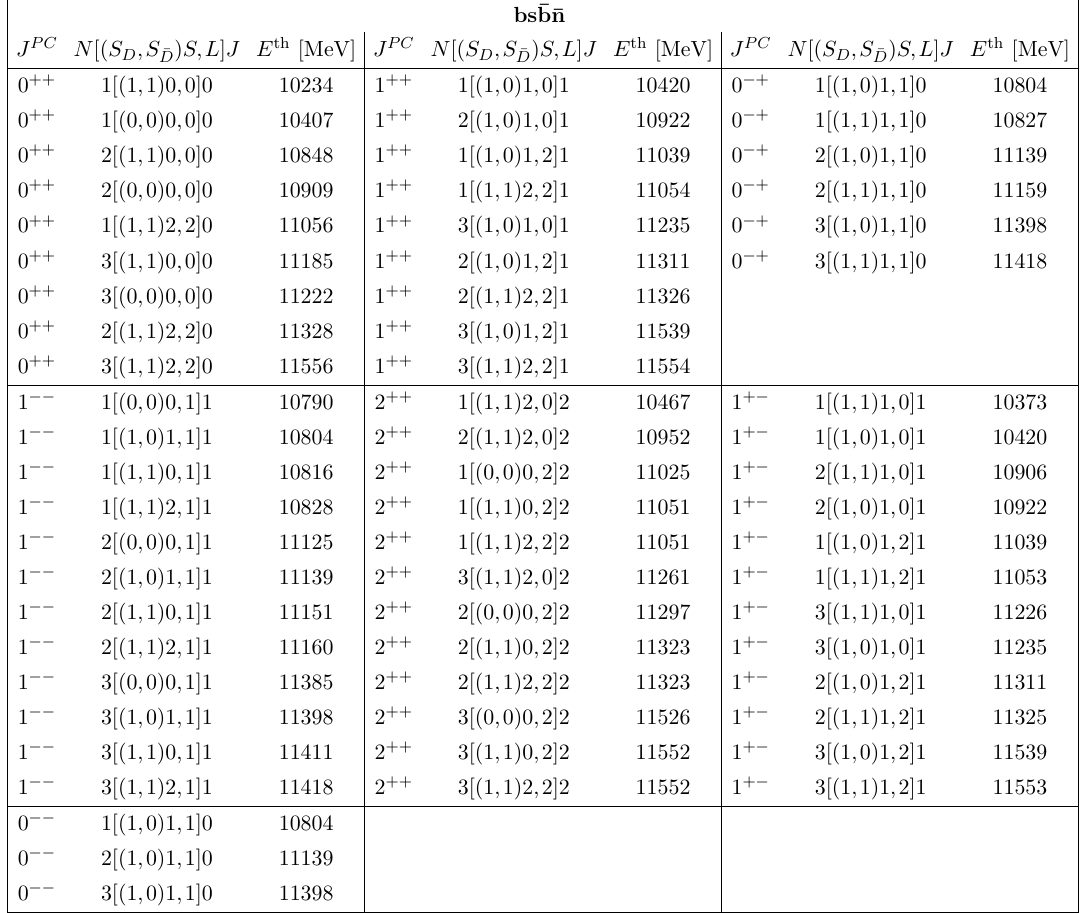
Table 8 . As table 7, but for bs (cid:22) b (cid:22) n ( bn (cid:22) b (cid:22) s )